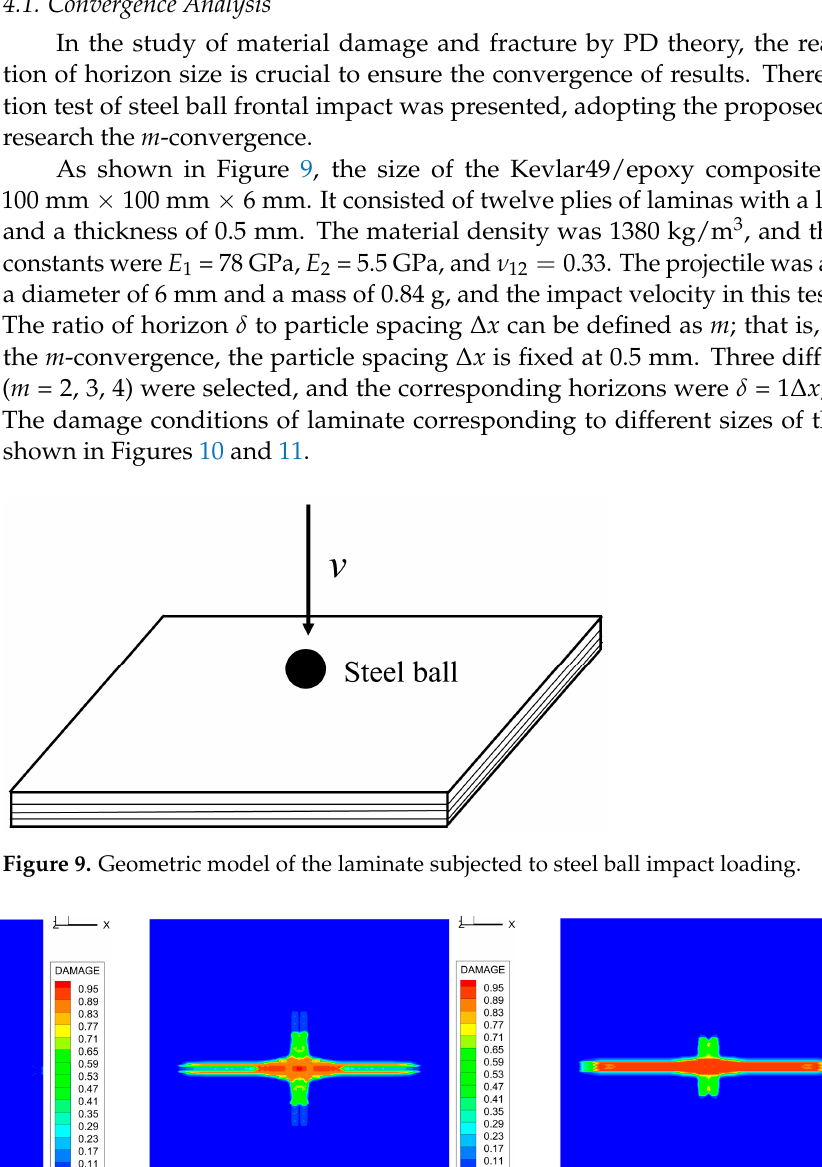
Figure 10. Damage pattern of composite laminate (front surface).